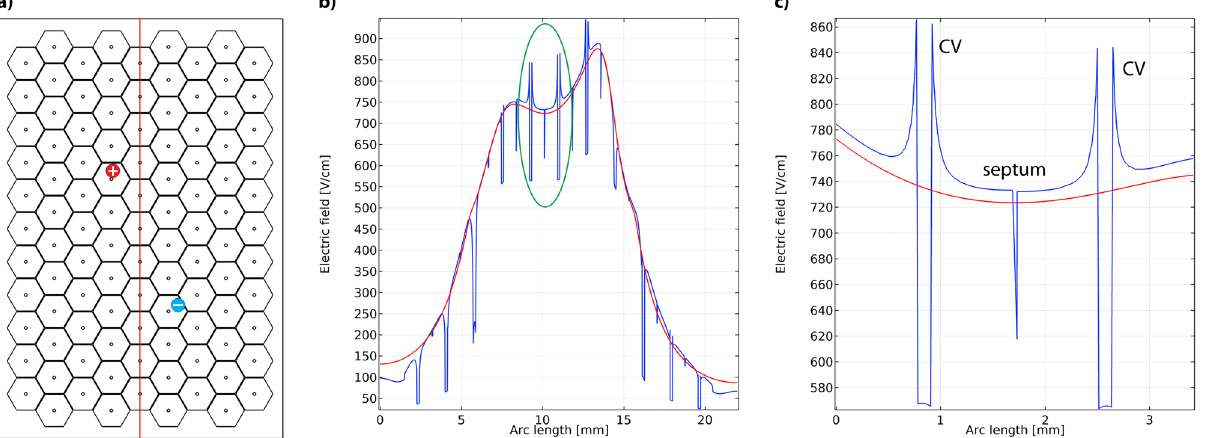
Figure 3. ( a ) A section of the model, showing two electrodes (red–cathode, blue–anode) and the cut-line (red vertical line). (b) Electric field strength along the cut-line crossing several septa and centrilobular veins (CV). ( c ) A close up of a section (indicated in green on panel ( b ) showing two lobules with CVs separated by a septum. Red lines on panels ( b ) and ( c ) show the electric field computed with a completely homogenous